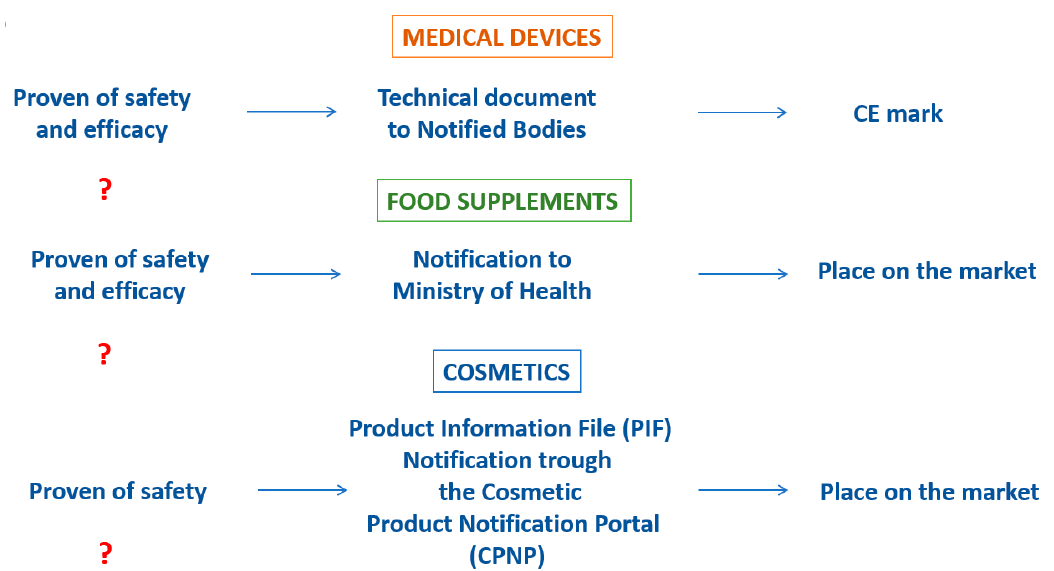
Figure 6. Clinical trials for not-pharmaceutical products: the state of the art (source: www.brainandlife.org). Figure6. Clinicaltrialsfornot-pharmaceuticalproducts: thestateoftheart(source: www.brainandlife.org). So, how a not-pharmaceutical product is considered safe and e ff